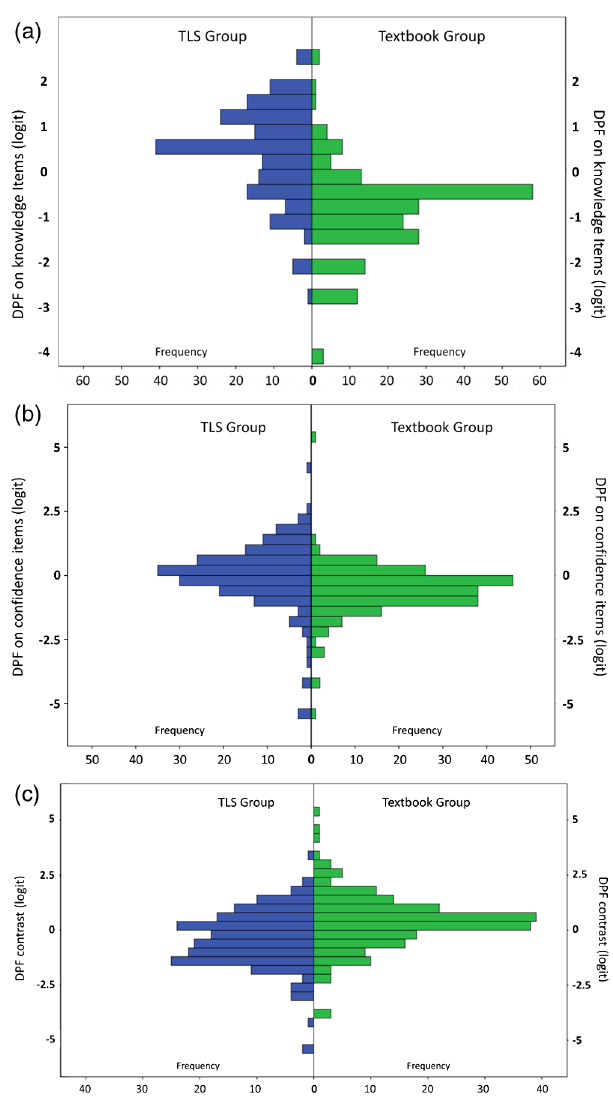
FIG. 6. Distribution of TLS and textbook control group students ’ DPF: (a) on knowledge items; (b) on confidence items; (c)